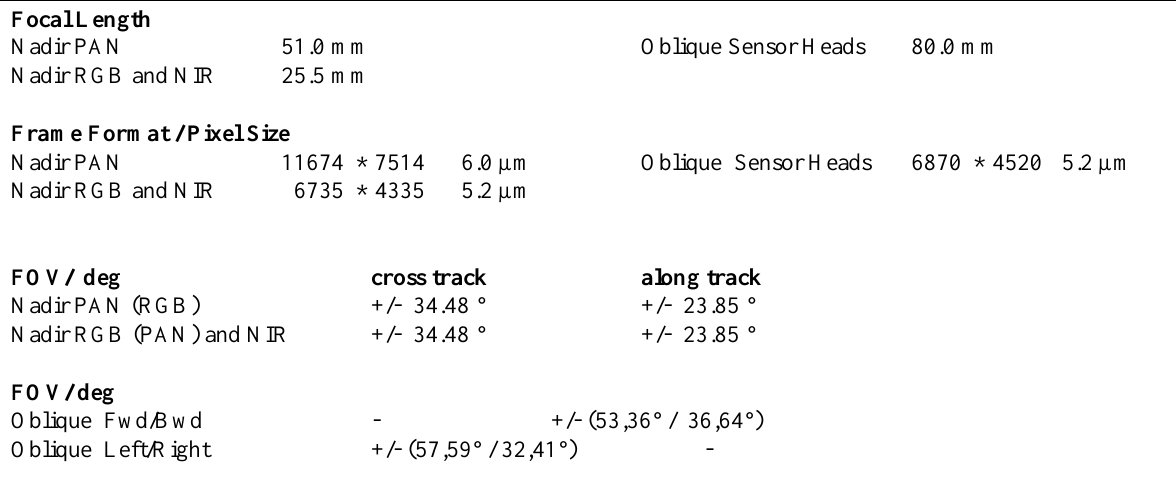
Table 1: Principal design parameters of the UltraCam